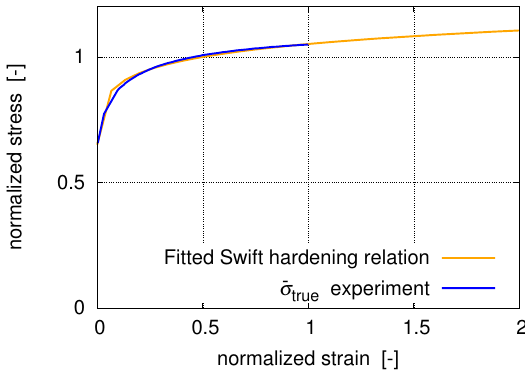
Figure 19. Fitted curve to experimental results, normalized with respect to the mean ultimate tensile strength and mean uniform strain,